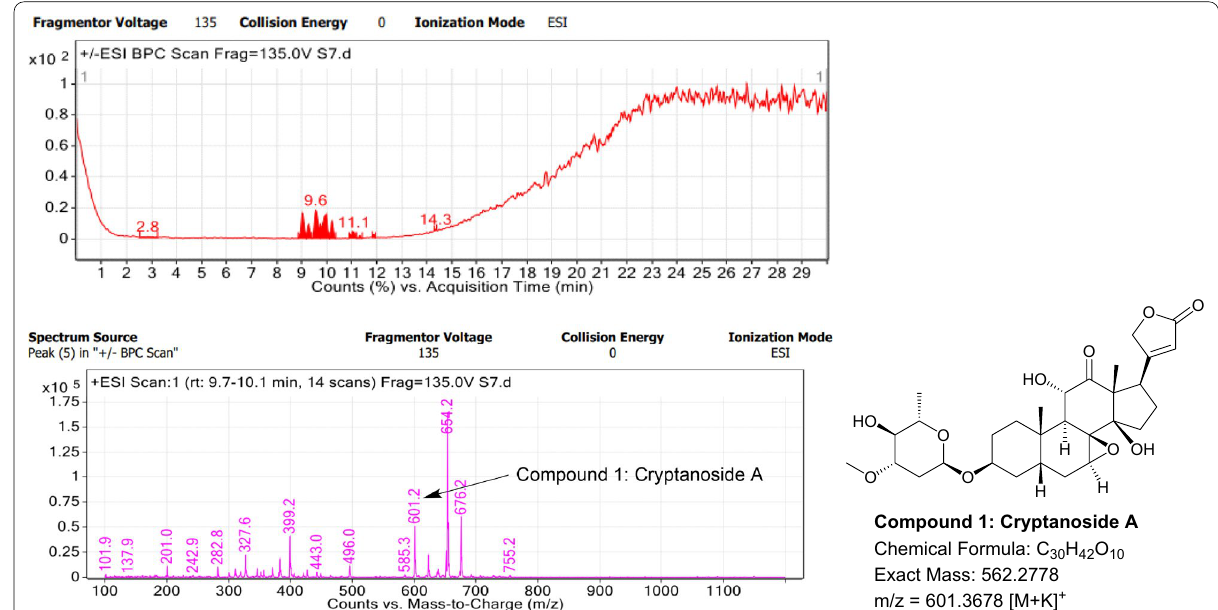
Fig. 13 LC–MS chromatogram of root extract of Cryptolepis dubia showing marker